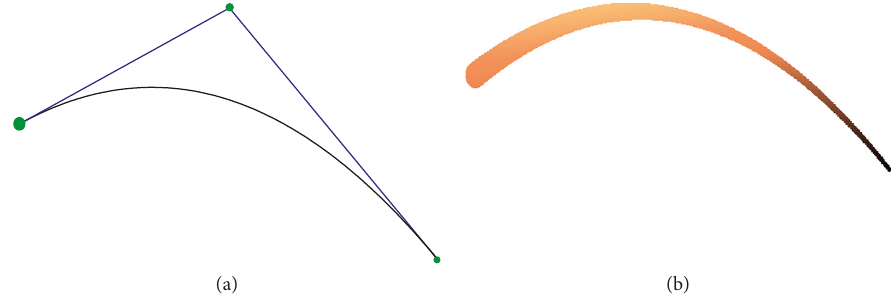
Figure 1: A quadratic BBC with skeleton and control balls. (a) Skeleton and control balls. (b) Quadratic